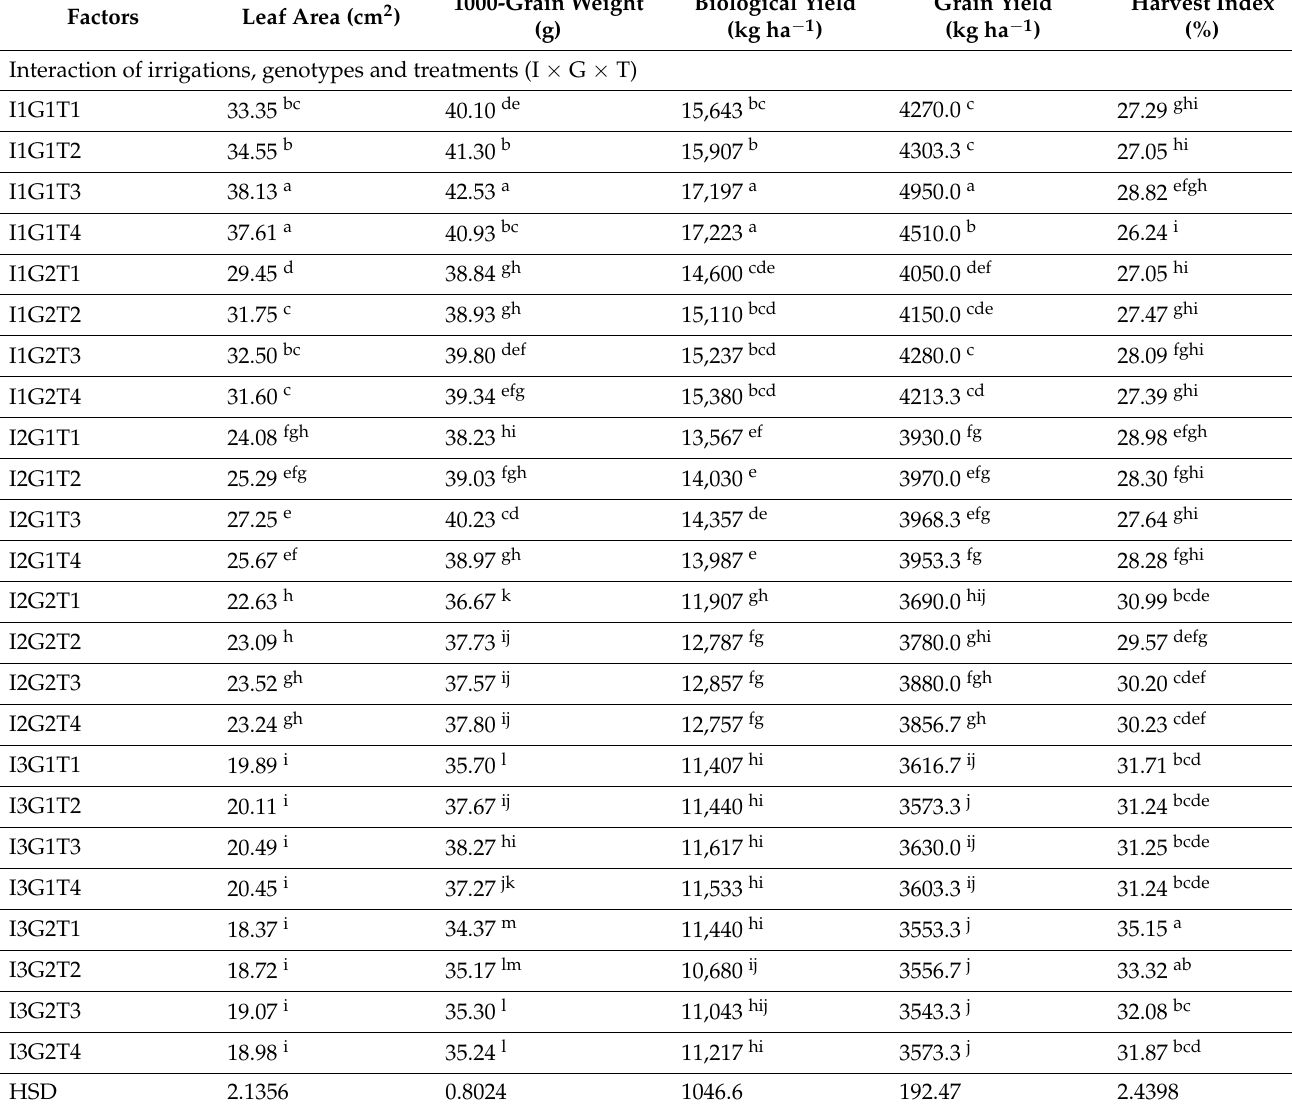
Table 9. Interactive response of all factors regarding leaf area, 1000-grain weight, biological yield, grain yield and harvest index of triticale